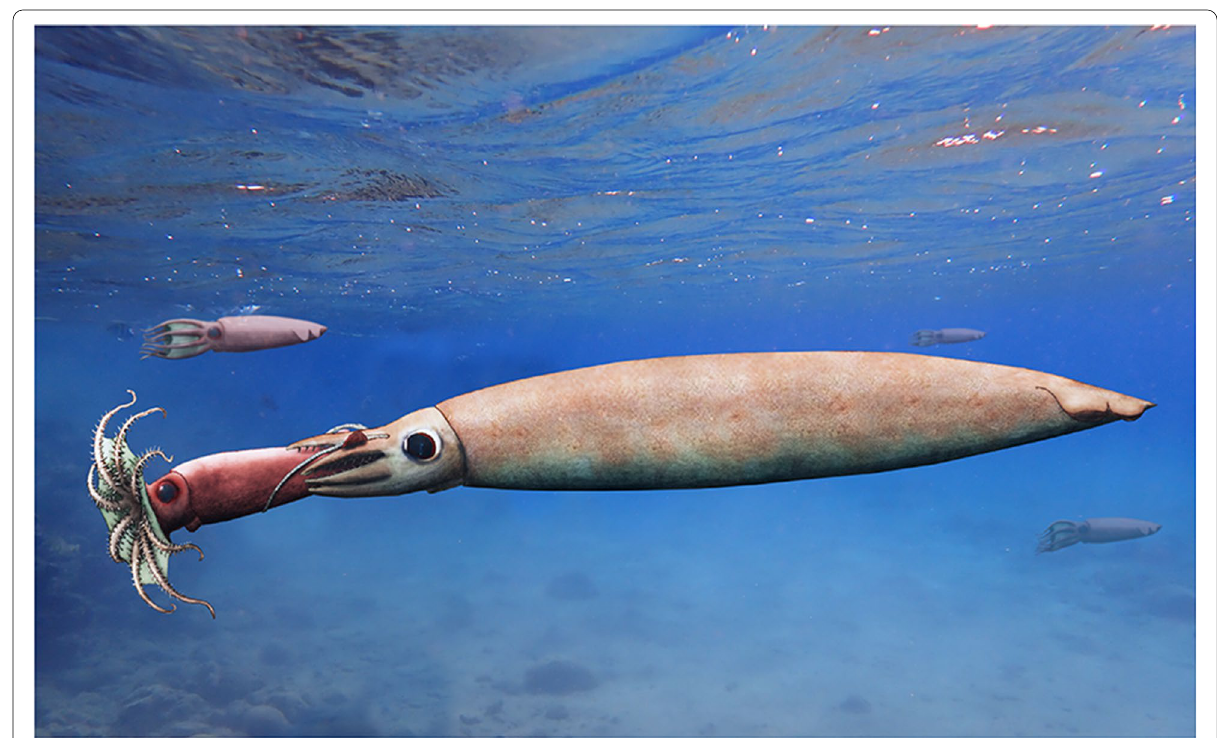
Fig. 4 Reconstruction of the Toarcian Jeletzkyteuthis coriacea catching a smaller specimen of Parabelopeltis